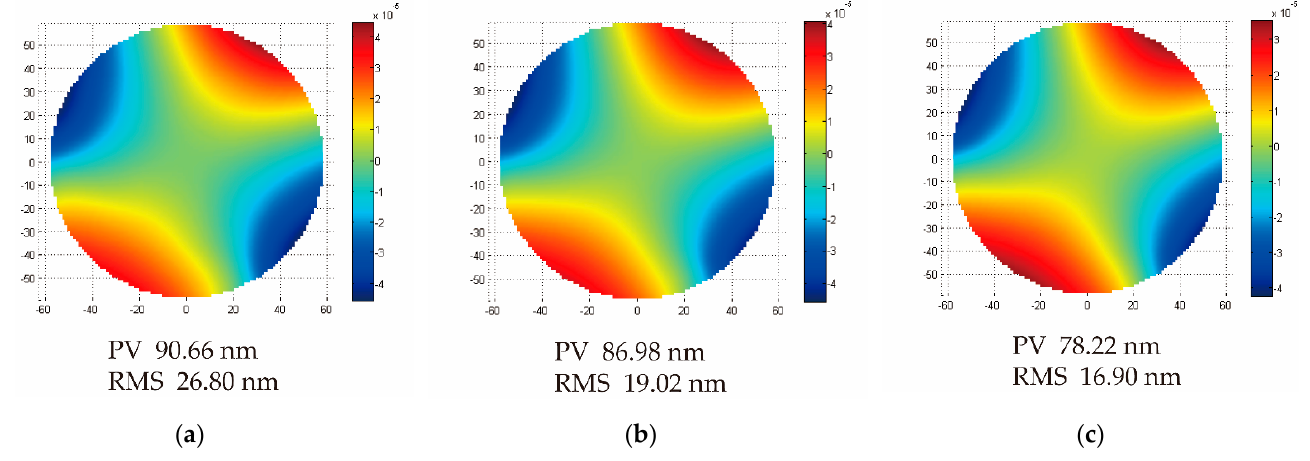
Figure 13. Surface shape fitting nephograms after the forced displacement analysis: ( a ) honeycomb mirror; ( b ) 2.5D − Voronoi mirror; and ( c ) 3D − Voronoi mirror.